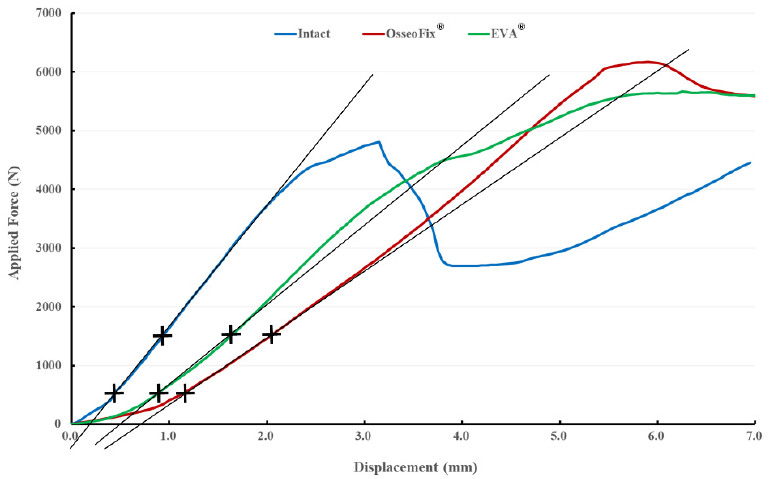
Figure 9. A typical force versus displacement curve for calculation of compression stiffness in the compression test. Compression stiffness was arbitrarily defined as the slope of the force-displacement curve between 500 N and 1500 N. Forces at 500 N and 1500 N are indicated with the “+” symbol.